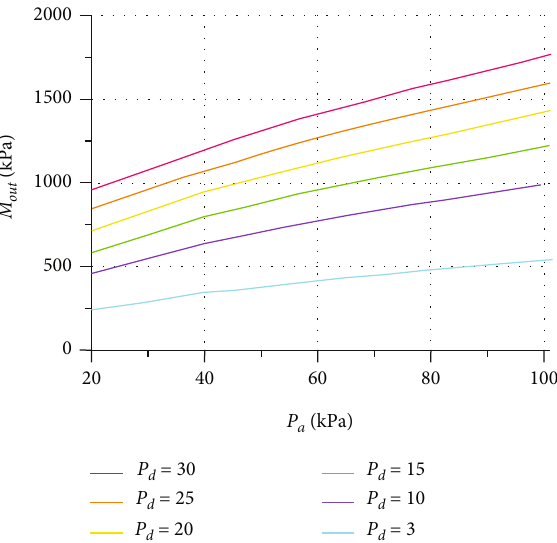
Figure 13: Relation between balance diaphragm pressure P relative valve opening x at di ff erent di ff erential pressure P d .